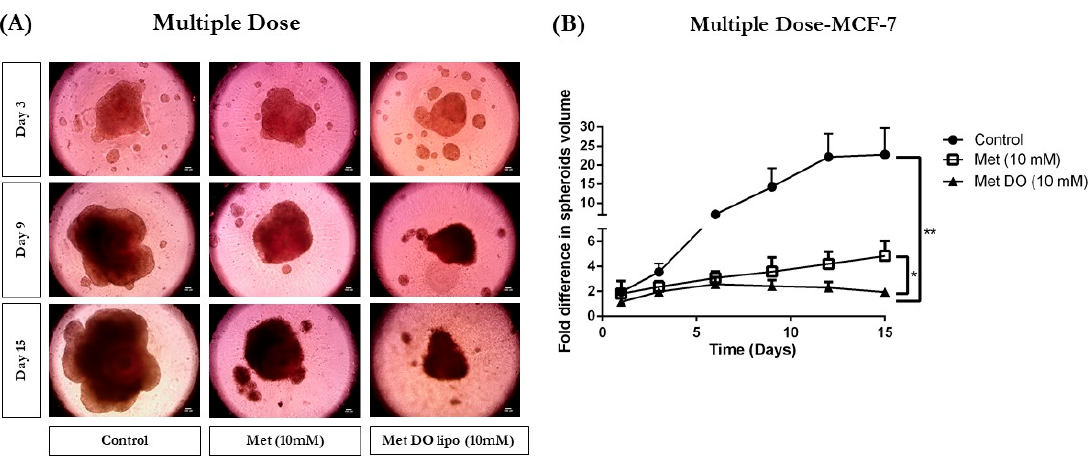
Figure 11. Effect of treatment on tumorigenic activity of MCF-7 cells grown as 3D spheroids simulating conditions of in vivo tumor. ( A ) Images of spheroids demonstrating a difference in size at days 3, 9, and 15 after multiple dose treatment. ( B ) Quantitative representation of anti-tumor activity of treatment expressed as fold difference in spheroid volume versus time for multiple-dose treatment. The multiple-dose treatment with Met DO lipo after 15 days resulted into significant difference ( p < 0.01) compared to control and p < 0.05 versus plain drug (Met) itself. Data represent mean ± SEM ( n = 6). Scale bar = 100 μ m. * p < 0.05 and ** p < 0.01.